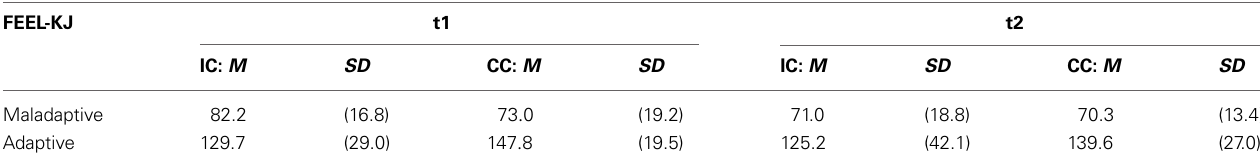
Table 2 | Mean and standard deviation of the FEEL-KJ-scales adaptive and maladaptive emotion regulation for intervention-class (IC) and control class (CC) at t1 and